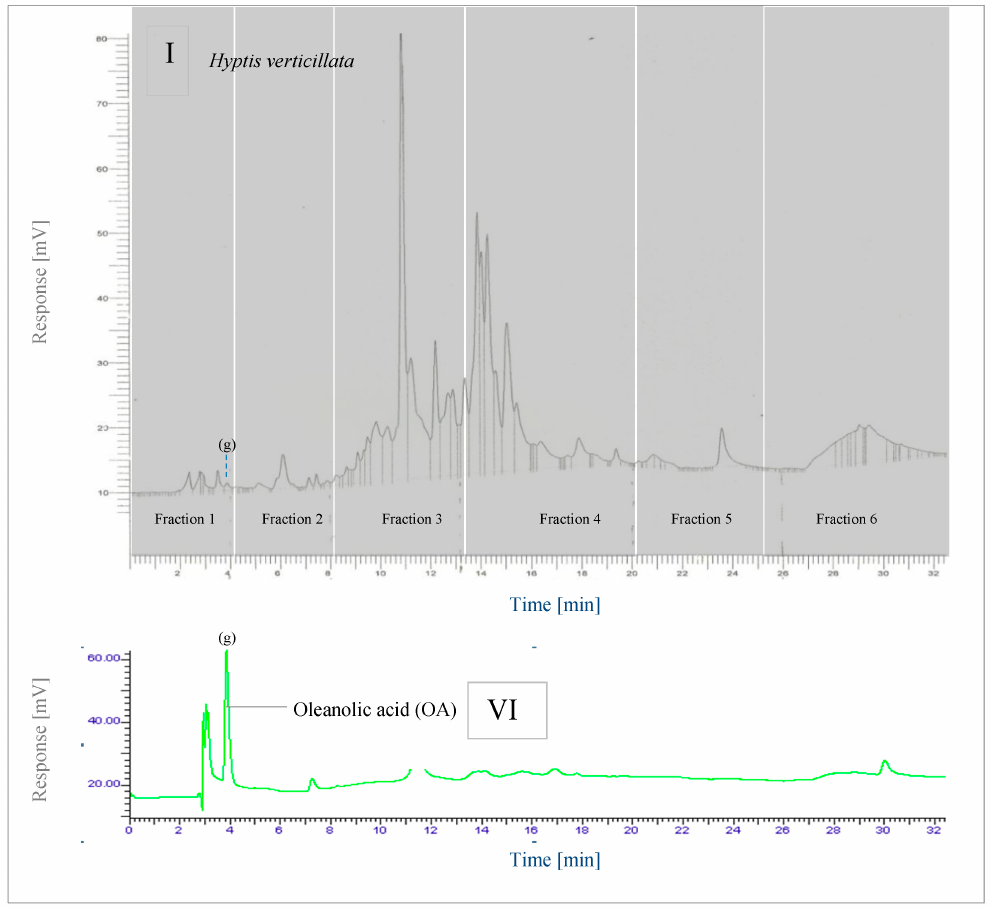
Figure A2. RP-HPLC analysis of reconstituted aqueous extract of H. verticillata ( I ) with comparison to standard: oleanolic acid ( VI ) [7.8 mM]. Separations were achieved using a Perkin-Elmer